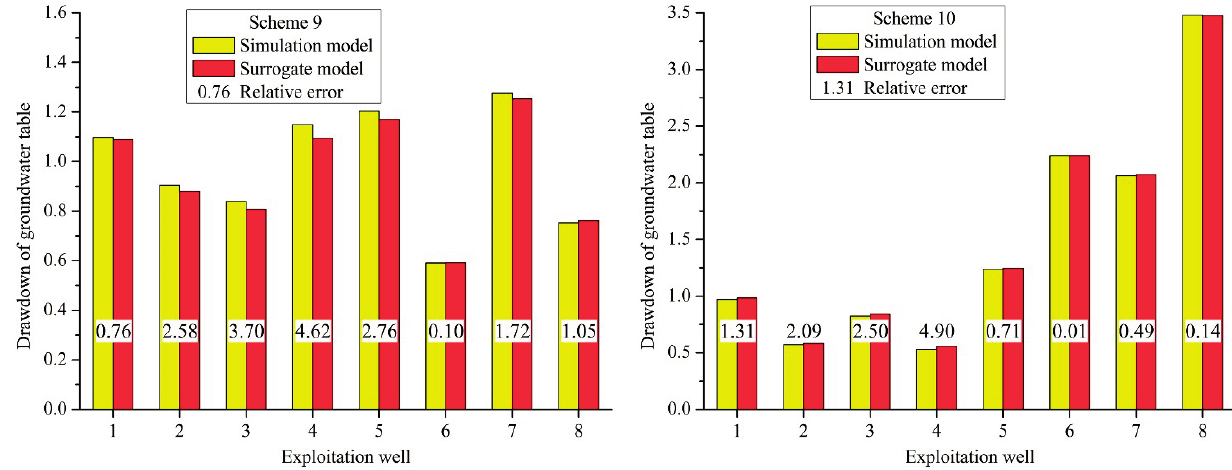
Figure 9. Value and relative error of groundwater table drawdown of the simulation model and surrogate model.